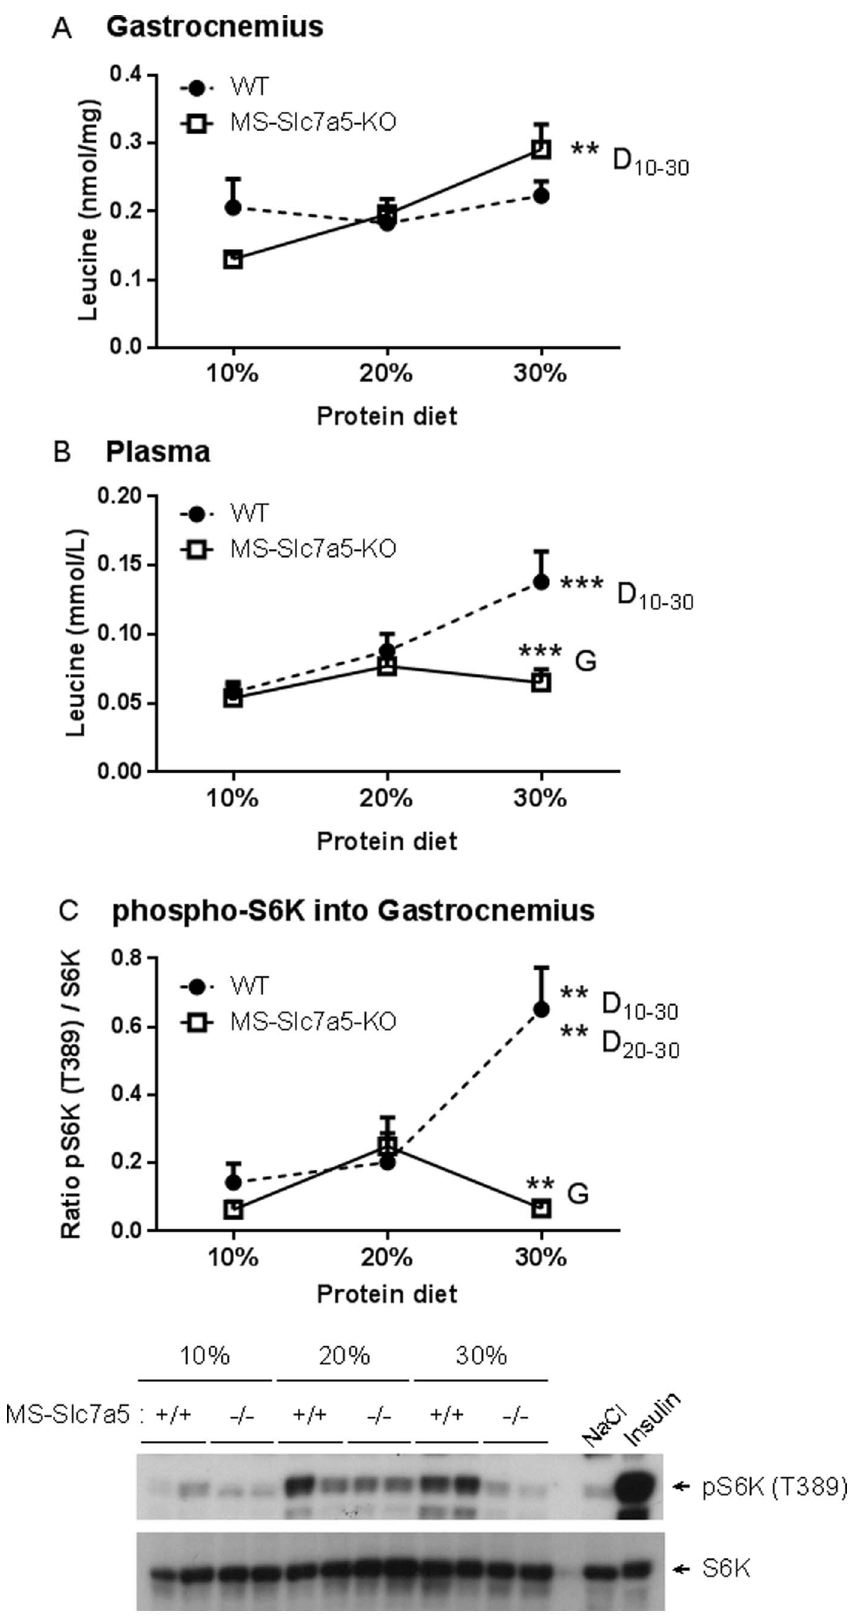
Figure 6. Altered dietary protein intake affects plasma and intramuscular AA concentrations and mTORC1 pathway signalling in MS- Slc7a5 -KO mice. Mean 6 SEM for n=6–10 (WT) and 3–5 (MS- Slc7a5 -KO) male mice. (A) There were significant effects of dietary protein content